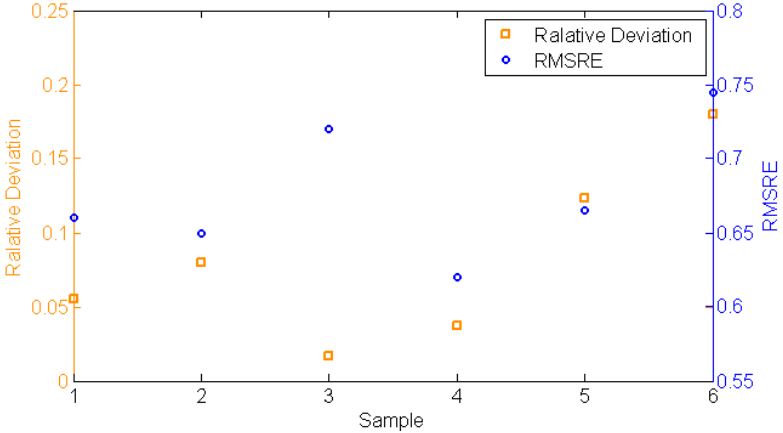
Figure 14. The comparison of radiance.